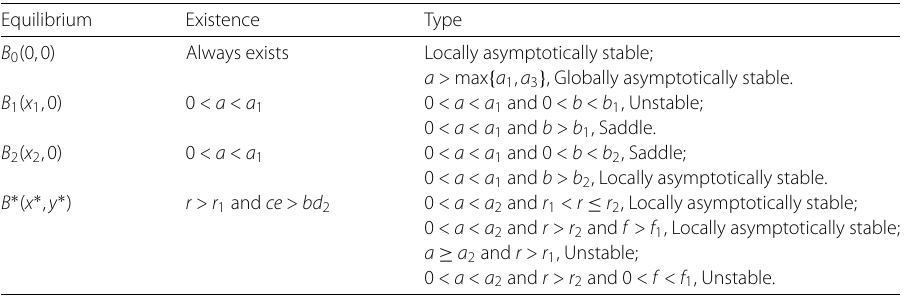
Table 2 Stationary states and their stability in model (1.3) Equilibrium Existence Type B 0 (0,0) Always